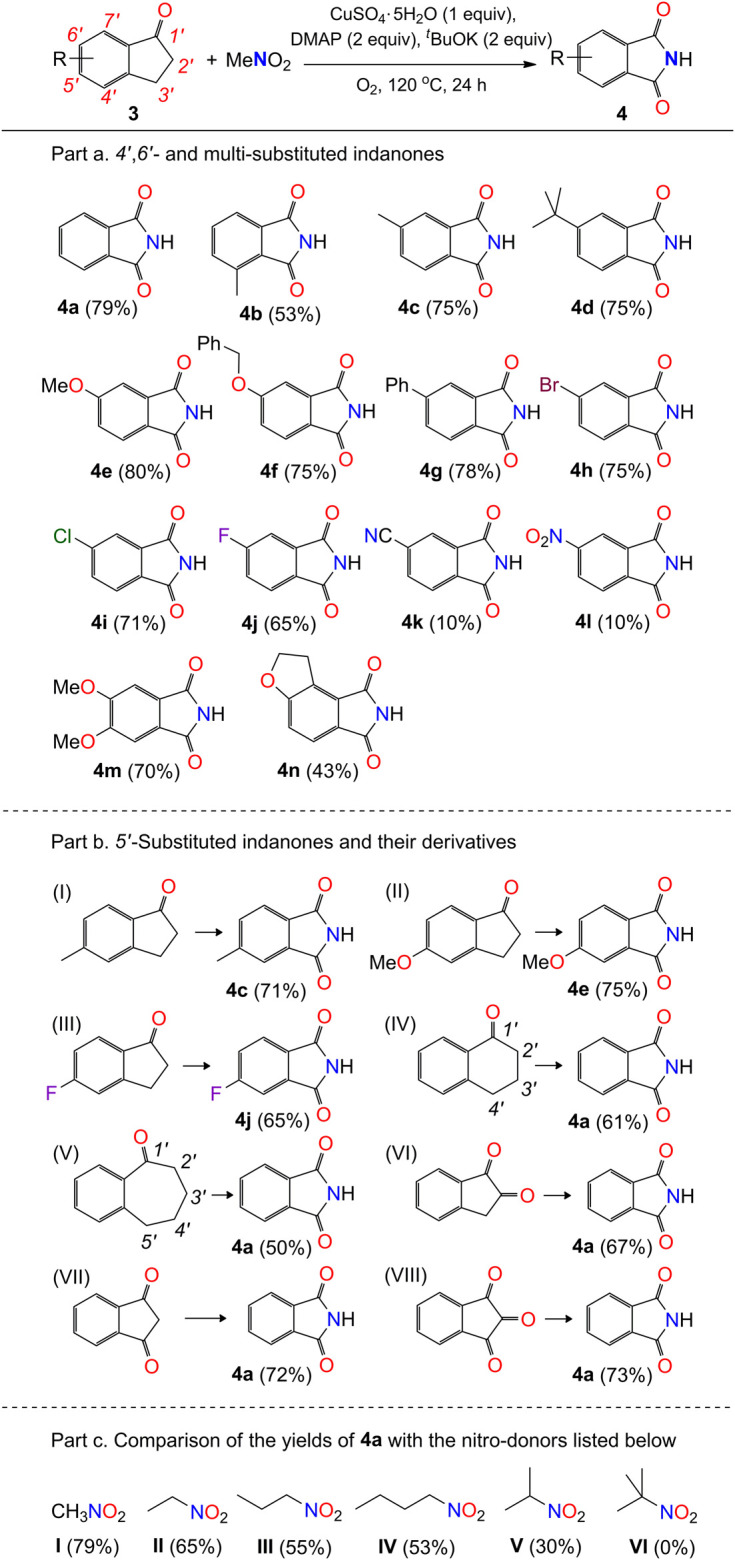
Scope of indanones with respect to compound 4a. aReaction conditions: substrate 3 (0.2 mmol), MeNO2 (1 mL), CuSO4.5H2O (0.2 mmol), DMAP (0.4 mmol), tBuOK (0.4 mmol), O2 (1 atm), 120 °C, and 24 h.